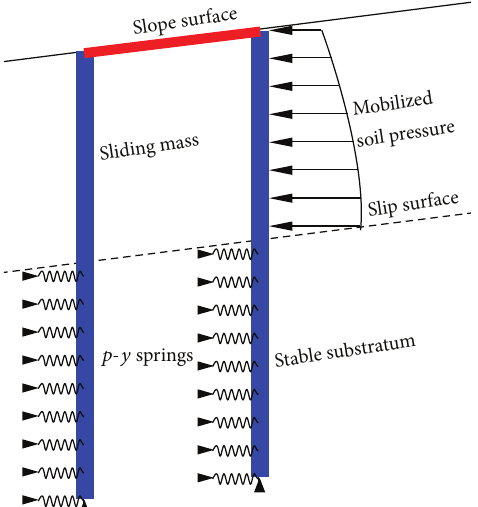
Figure 1: The uncoupled analysis model for the double-row portal stabilizing